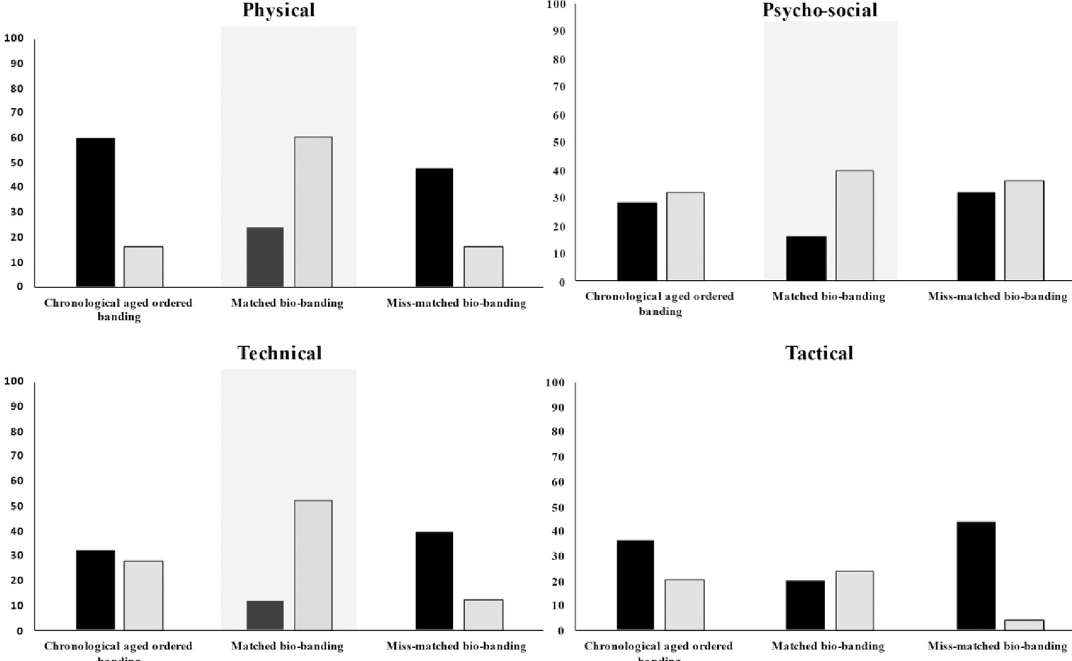
Fig 1. Percentage distribution of practitioner aggregated (i.e., sum of strongly disagree and disagree; sum of strongly agree and agree) perceived agreement (Black–Disagree; Grey–Agree) of whether they agree chronologically ordered formats (U11, U12, U13 etc), maturity matched (i.e. early vs early, post-PHV vs Post-PHV etc) or maturity miss-matched (i.e. early vs early, pre-PHV vs Post-PHV etc) bio-banding is the most effective strategy to create an environment to assess players physical, psycho-social, technical and tactical